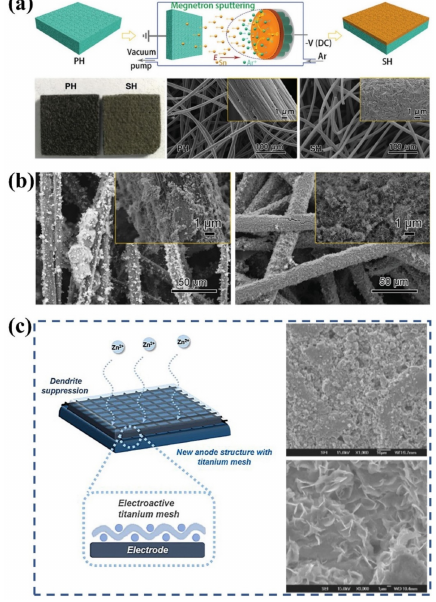
Figure 4. ( a ) Schematic diagram for the fabrication process of tin-modified electrodes, the morpholo- gies of the pristine carbon felt (PH) and the tin-modified carbon felt (SH). ( b ) SEM images of the pristine carbon felt (left) and the tin-modified carbon felt (right) after charging. (Reproduced from [43] with permission from Wiley.) ( c ) Schematic diagram of the electrode with titanium mesh and SEM morphologies of the electrode with (top right) and without (bottom right) titanium mesh after initial Zn deposition. (Reproduced from [44] with permission from